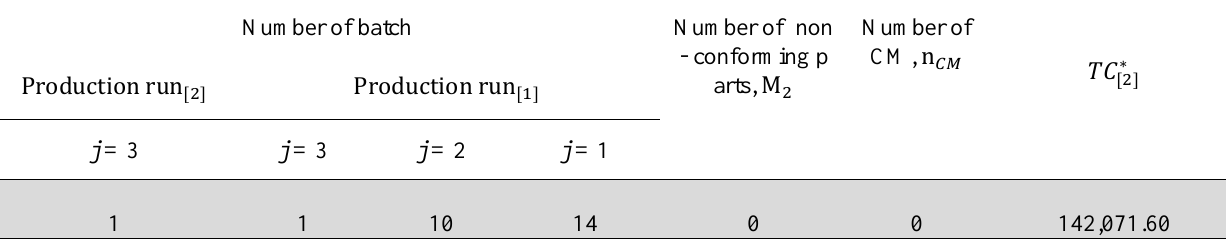
The decision variable of the best solution for 2 nd looping ( k = 2) Number of batch